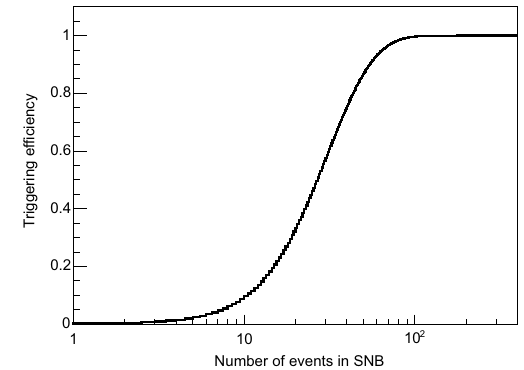
Fig. 13 Supernova neutrino burst triggering efficiency for the DP pho- ton detectors as a function of the number of interactions in one module of the dual phase active volume for the wavelength-shifting reflective half-foil configuration of the baseline